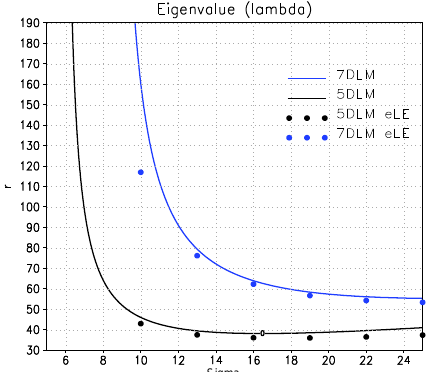
Figure 5. Stability analysis for the linearized Lorenz models with (cid:49)σ = 0.01 and (cid:49)r = 0.1 in the 5DLM and 7DLM. The leading eigenvalue Re ( λ ) as a function of σ and r . The black and blue lines indicate a constant contour of Re ( λ ) = 0 for the locally linear 5DLM and 7DLM, respectively. Solid circles with the same color scheme indicate a r c determined by the eLE analysis with (cid:49)r = 1.0 in the corresponding nonlinear